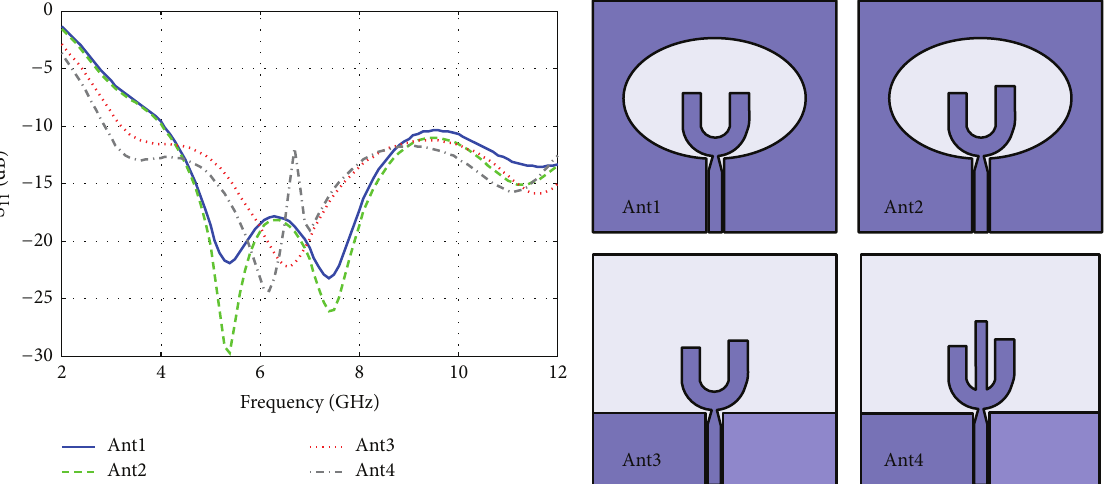
Figure 5: 𝑆 11 of miniaturization process.